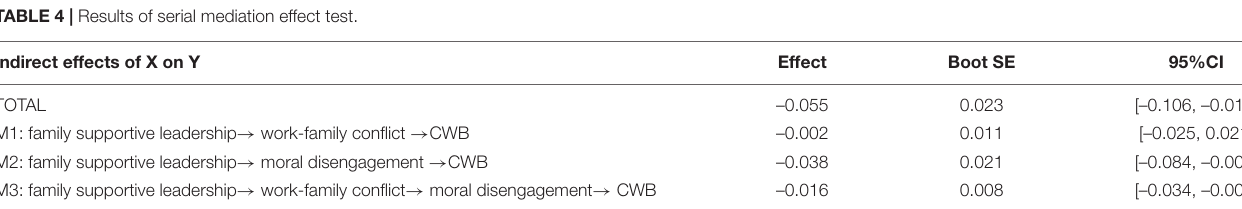
TABLE 4 | Results of serial mediation effect